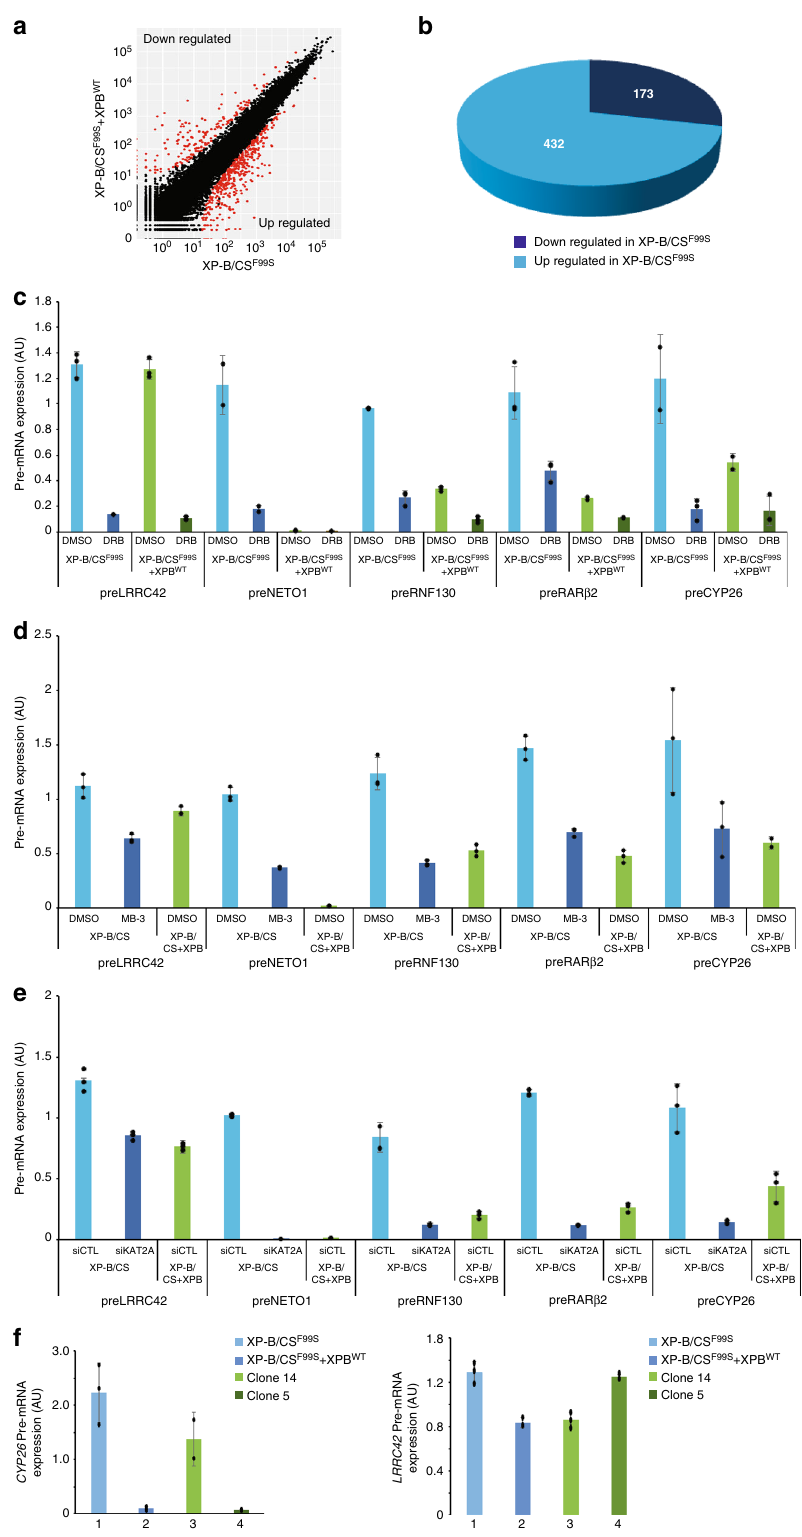
upregulated in XP-B/CS F99S cells. Their pre-mRNA levels were rapidly inhibited by 1h treatment with the inhibitor of class II gene expression 5,6-dichloro-1- β -D-ribofuranosylbenzimidazole (DRB) (Fig. 6c), indicating that we had ampli fi ed pre-mRNA. While LRRC42 pre-mRNA accumulation was similar in both cell lines, we detected a higher amount of NETO1 , RNF130 , RAR β 2,